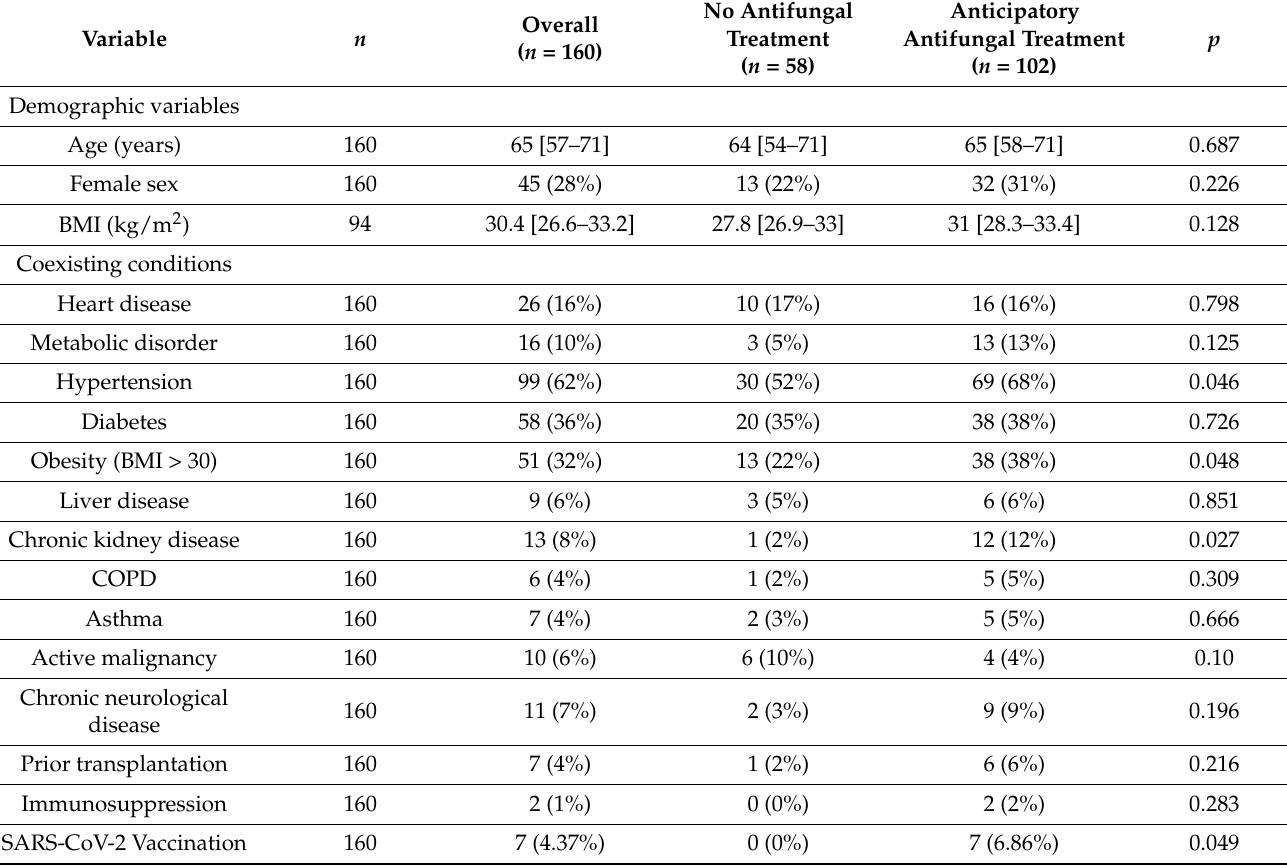
Table 1. Baseline characteristics of the study population on admission to the ICU.